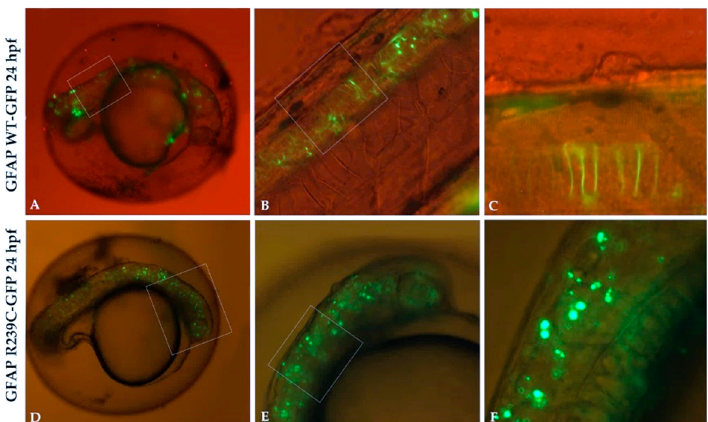
Figure 1. GFP expression in transgenic glial fibrillary acid protein (GFAP) wildtype (WT) and GFAP R239C embryos. ( A , B ) The expression of GFAP WT-GFP protein is visible along the neural tube, with very few GFAP aggregates observed. ( C ) High magnification of embryo in ( B ) shows GFAP WT protein as filamentous structures. ( D – F ) Several aggregates of p.R239C in the brain and along the neural tube are found. Magnification: 4 × ( A , D ); 10 × ( B , E ); 20 × ( C , F ). High magnification are shown by rectangular shape.